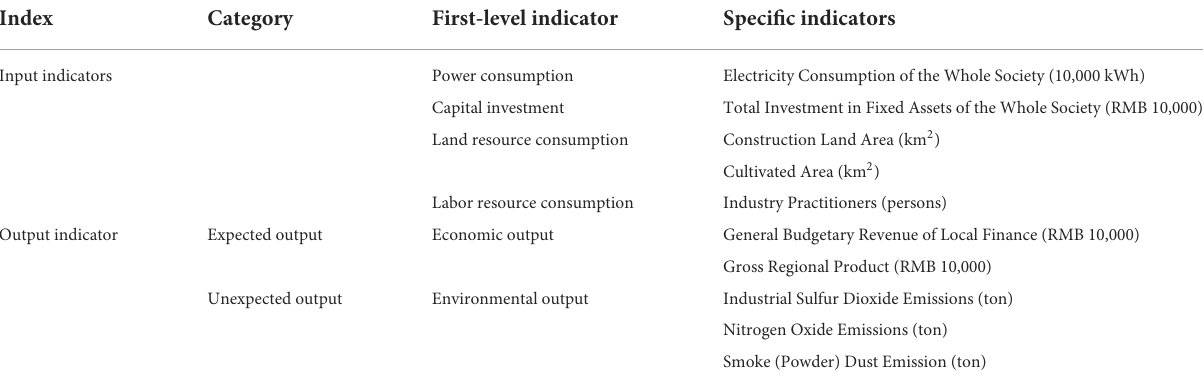
TABLE 2 County-level eco-efficiency evaluation